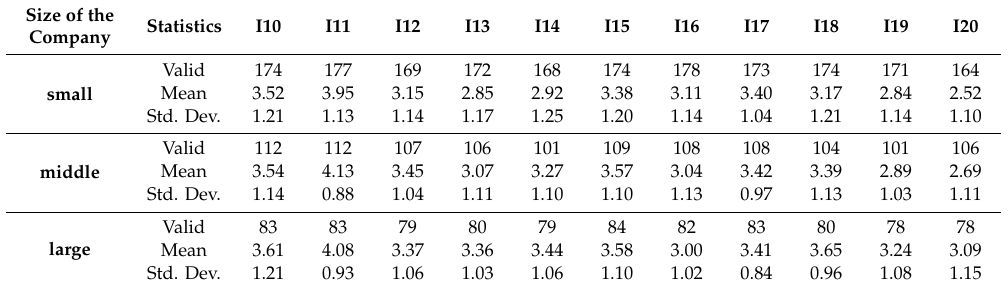
Table 8. ( A ) Significant di ff erences in talent identification according to size of the company (ANOVA)